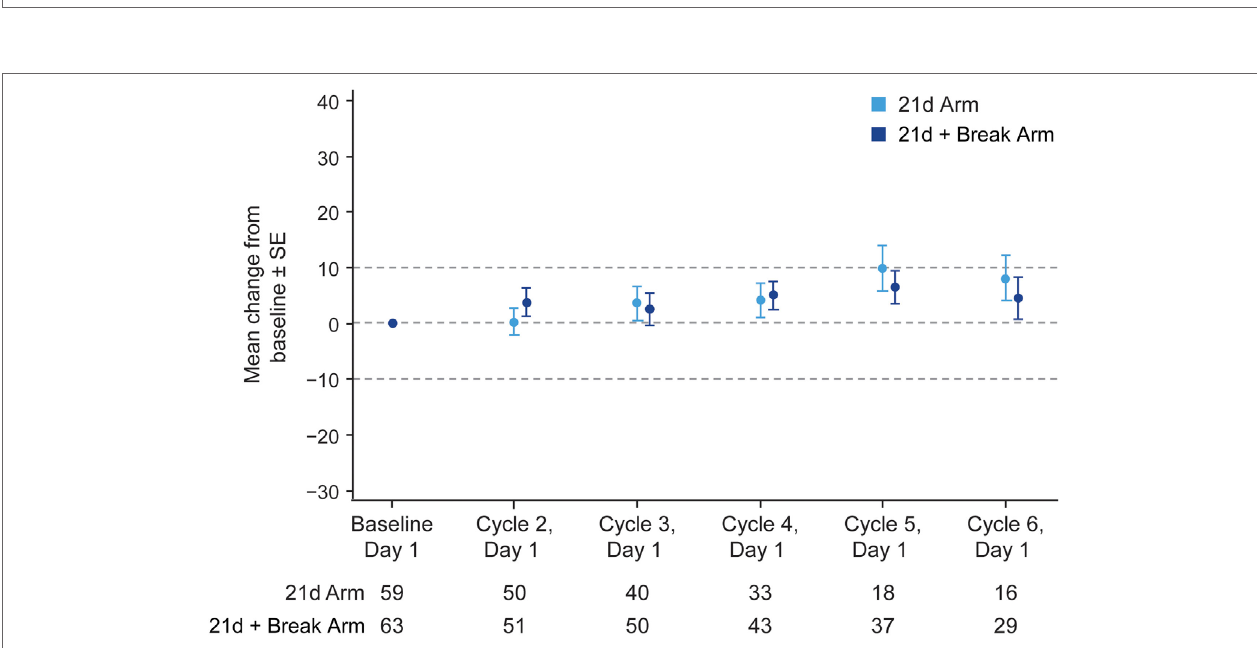
FigUre 4 | Mean maximum change from baseline in LCSS scores. Abbreviation: LCSS, Lung Cancer Symptom Scale. *Not all patients completed assessments in all